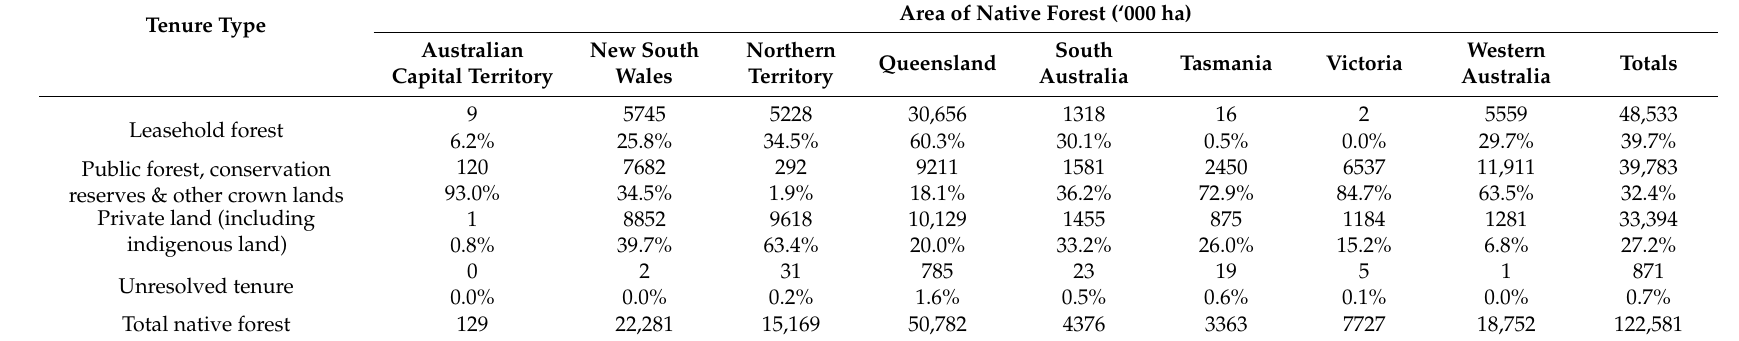
Table 1. Area and distribution of native forest, by tenure and